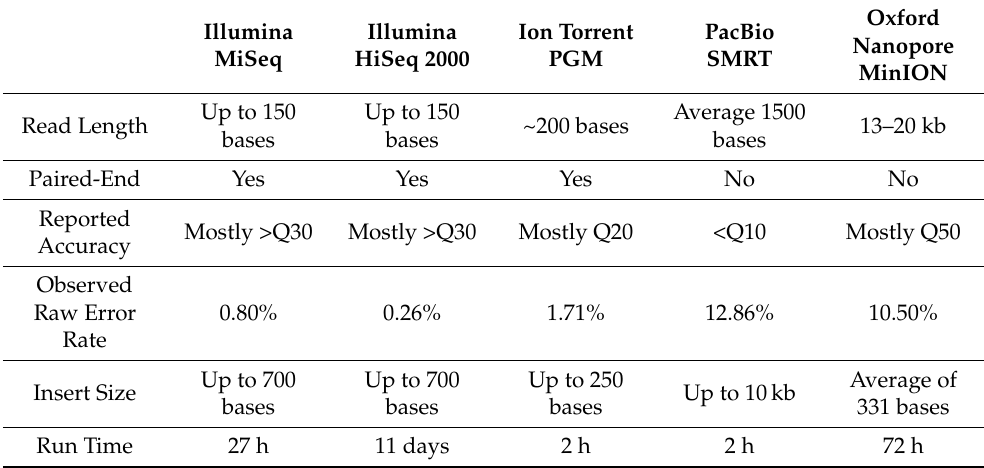
Table 1. Comparison of different NGS platforms: Illumina MiSeq, Illumina HiSeq 2000, Ion Torrent PGM, PacBio SMRT and Oxford Nanopore